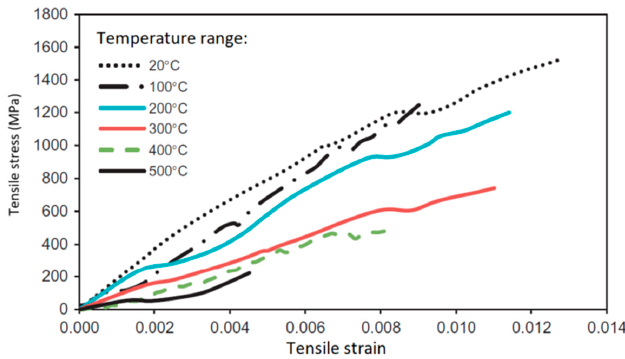
Figure 13. Stress–strain response of CFRP rods at different temperatures.